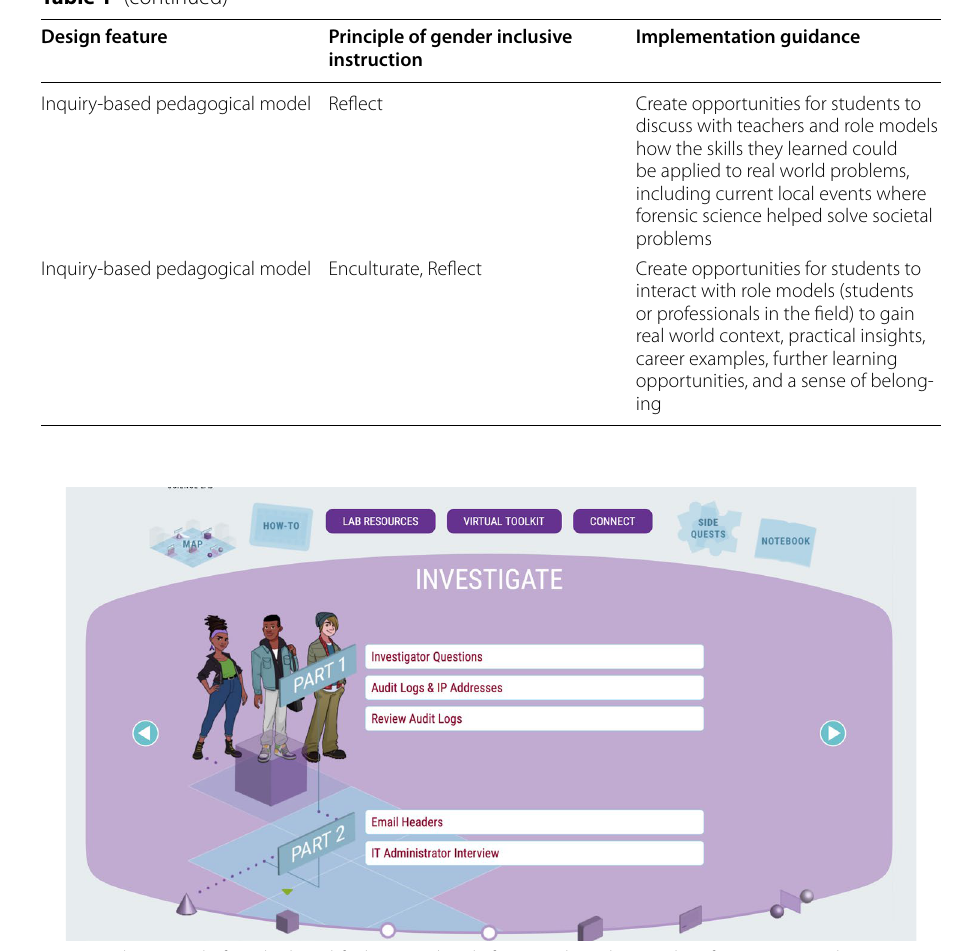
underrepresented youth, predominantly racial minorities in Baltimore, New Orleans, Las Vegas, and a Seattle school district. The CSSL modular design allows for flex- ibility to adapt materials to different educational settings. This flexibility allowed the program to be tested in a single day session, multiple full-day sessions, and across multiple weeks in different formats. Single day sessions focused on one mission with limited duration in-classroom activities and role model engagement, whereas longer sessions permitted expansion of all aspects of the CSSL program.